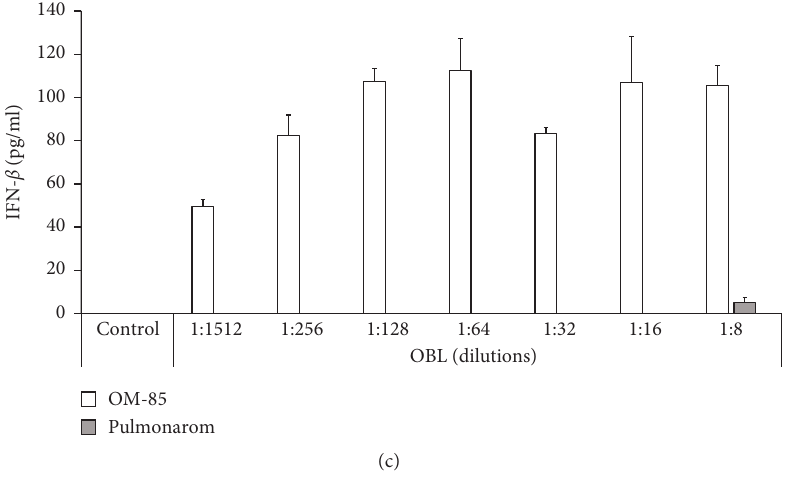
Figure 5: Bacterial lysate’s effect on in vivo secretion of TNF- α , IL-6, and IFN- β by dendritic cells. The concentration-dependent effect of pretreatment with OM-85 or Pulmonarom on the secretion of (a) TNF- α , (b) IL-6, and (c) IFN- β by mouse bone marrow-derived dendritic